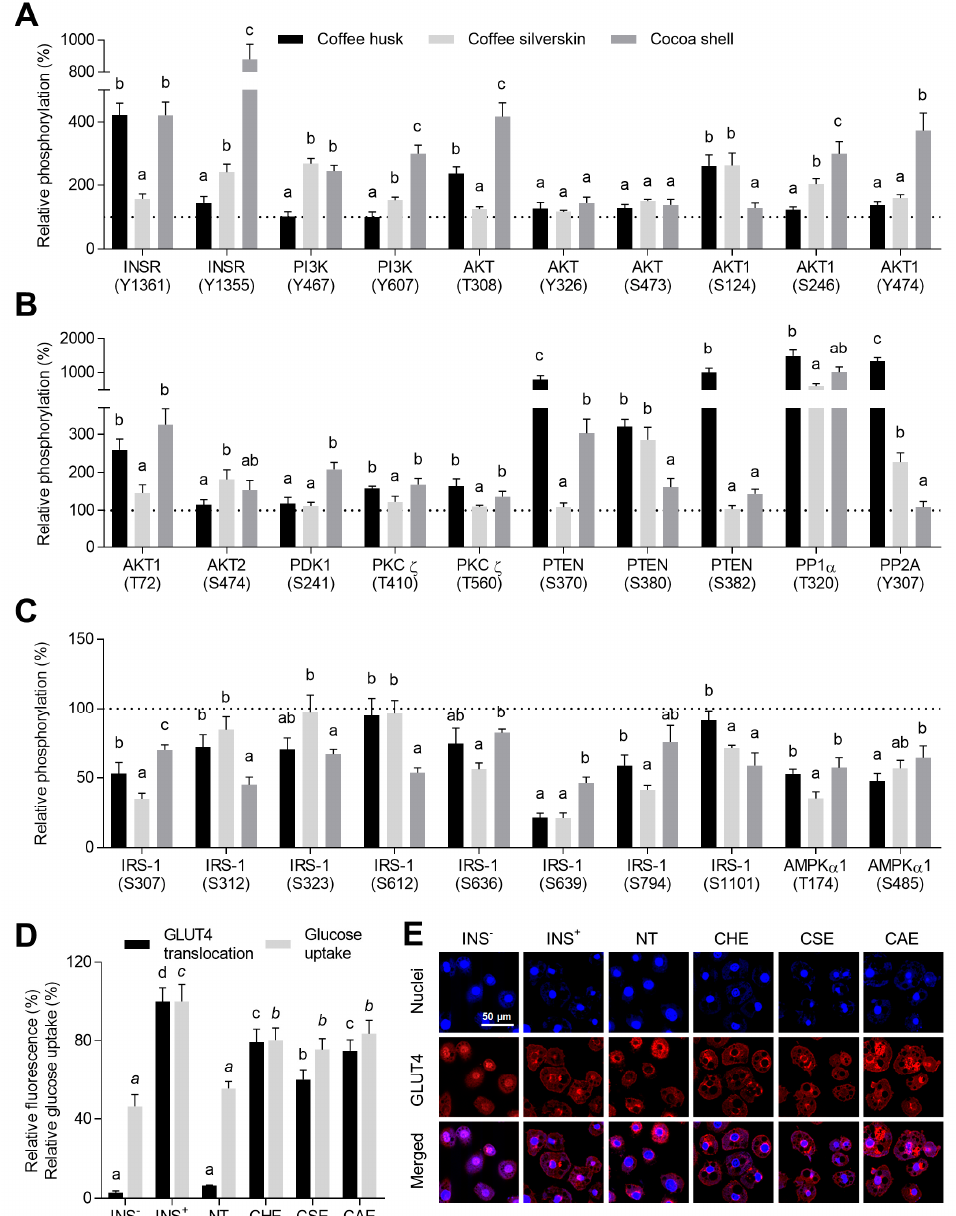
Figure 2. Insulin-sensitizing e ff ects of co ff ee husk, co ff ee silverskin, and cocoa shell aqueous extracts (125 µ g / mL) on adipocyte treated with the conditioned media from macrophages. Up-phosphorylated proteins ( A , B ) and down-phosphorylated proteins ( C ) from the insulin signaling pathway. GLUT4 translocation into the cell membrane measured as the relative fluorescence intensity between GLUT4 and the nucleus and glucose uptake ( D ), and confocal laser scanning microscopy representative images ( E ). INS: insulin; NT: non-treated cells; CHE: co ff ee husk extract; CSE: co ff ee silverskin extract; CAE: cocoa shell extract.